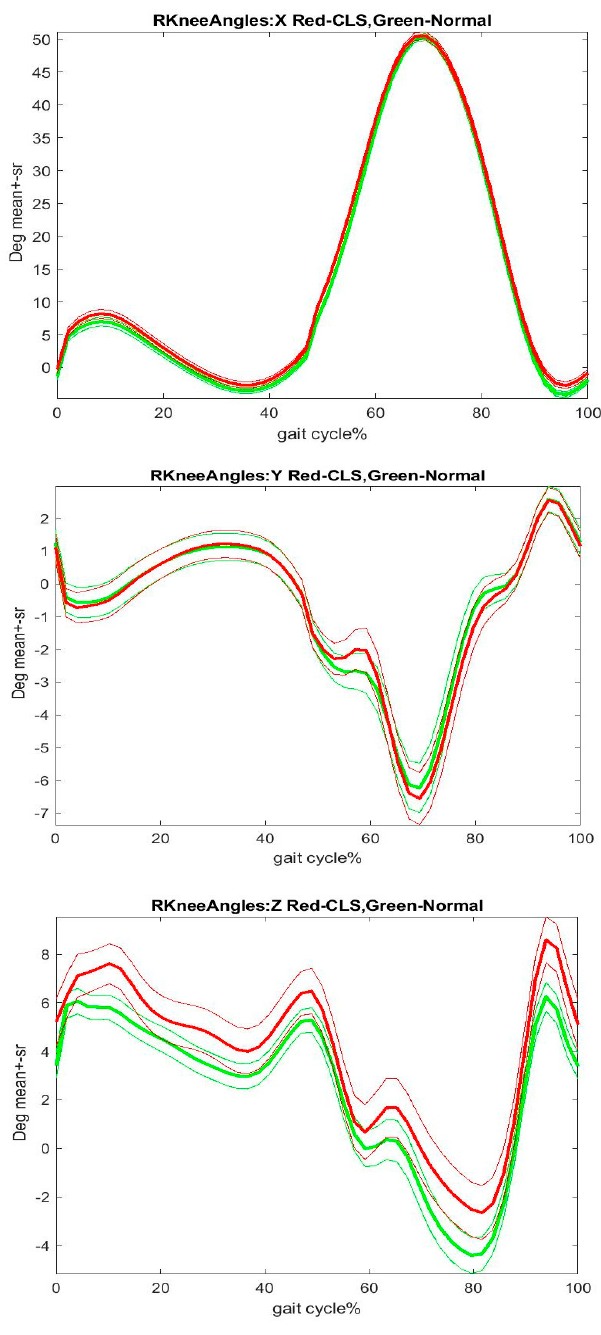
Figure 4. Knee angles’ comparison between before and after CLS in right side. Note: Green: before CLS, Red: after CLS; X, Y, and Z: the sagittal, coronal, and transverse planes. Thickness lines: mean, fine lines: standard error of mean. The curve patterns were plotted using right side 118 pair trials for before and after CLS, and some trails with gaps were removed. As the trails used to plot figures were resampled to 50 frames, there are slightly numeric differences between figures and tables. Nevertheless, the fi gures show the trends between before and after CLS.